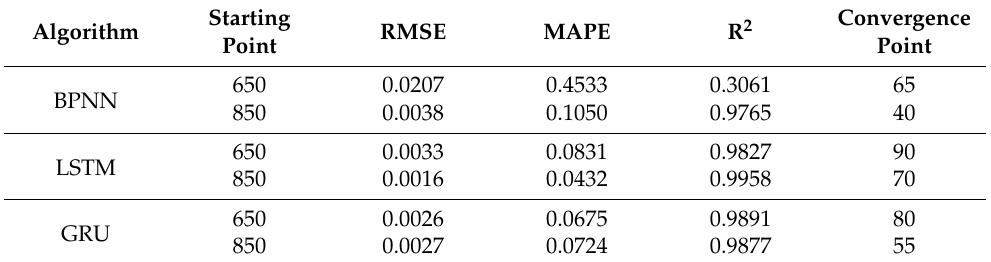
Table 3. Comparison of different neural networks and prediction starting